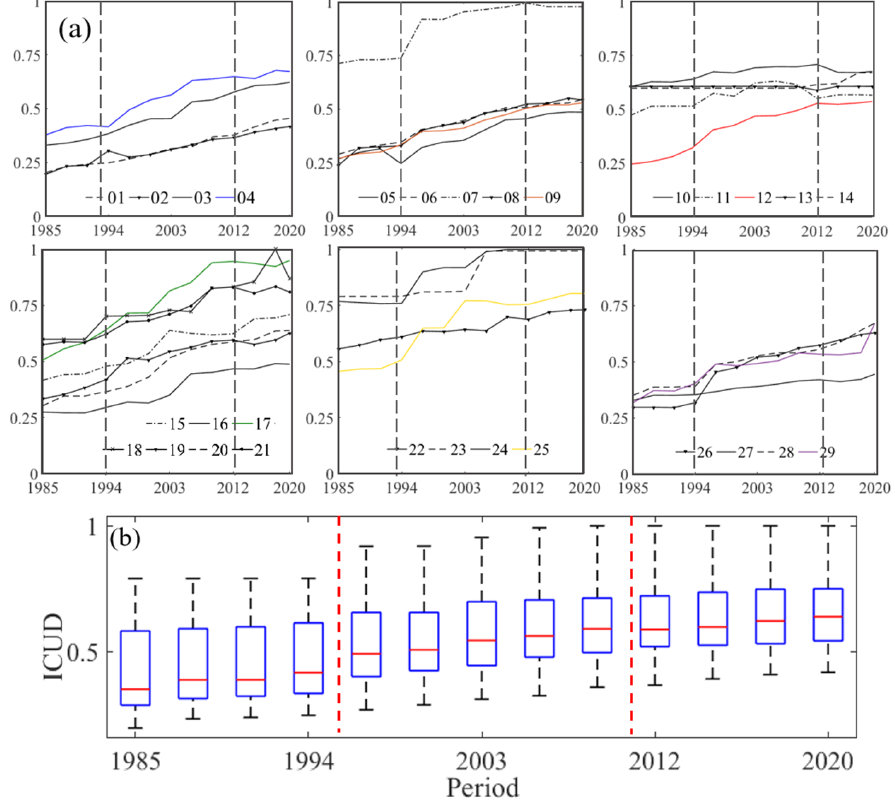
Figure 6. ( a ) The changing trend of ICUD in 29 counties; ( b ) Some basic statistical indicators of all ICUD in 13 different periods.